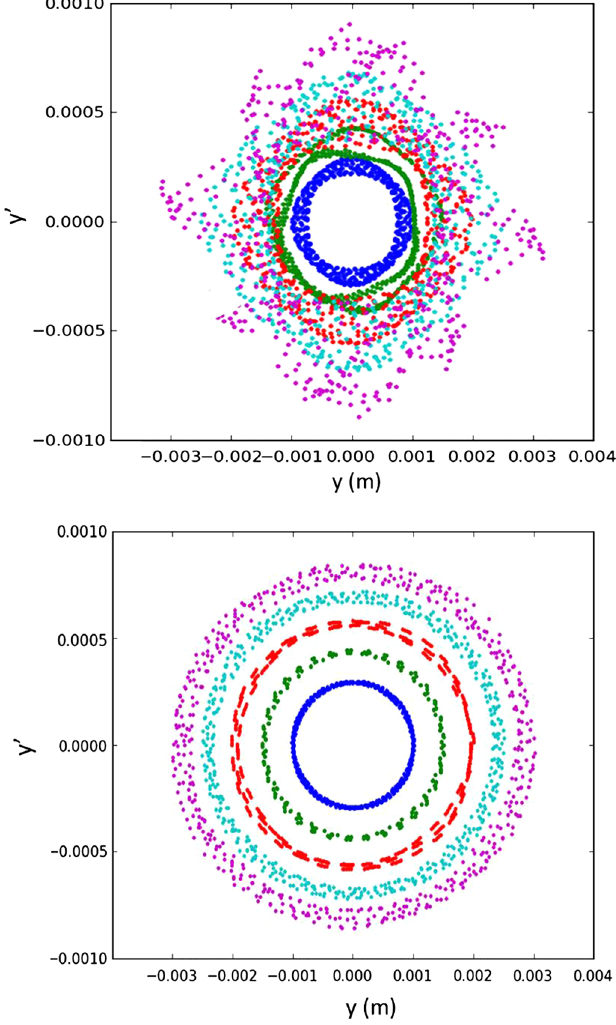
FIG. 13. Trajectories in the y − y 0 phase space for five particles before (top) and after optimization (bottom) by square